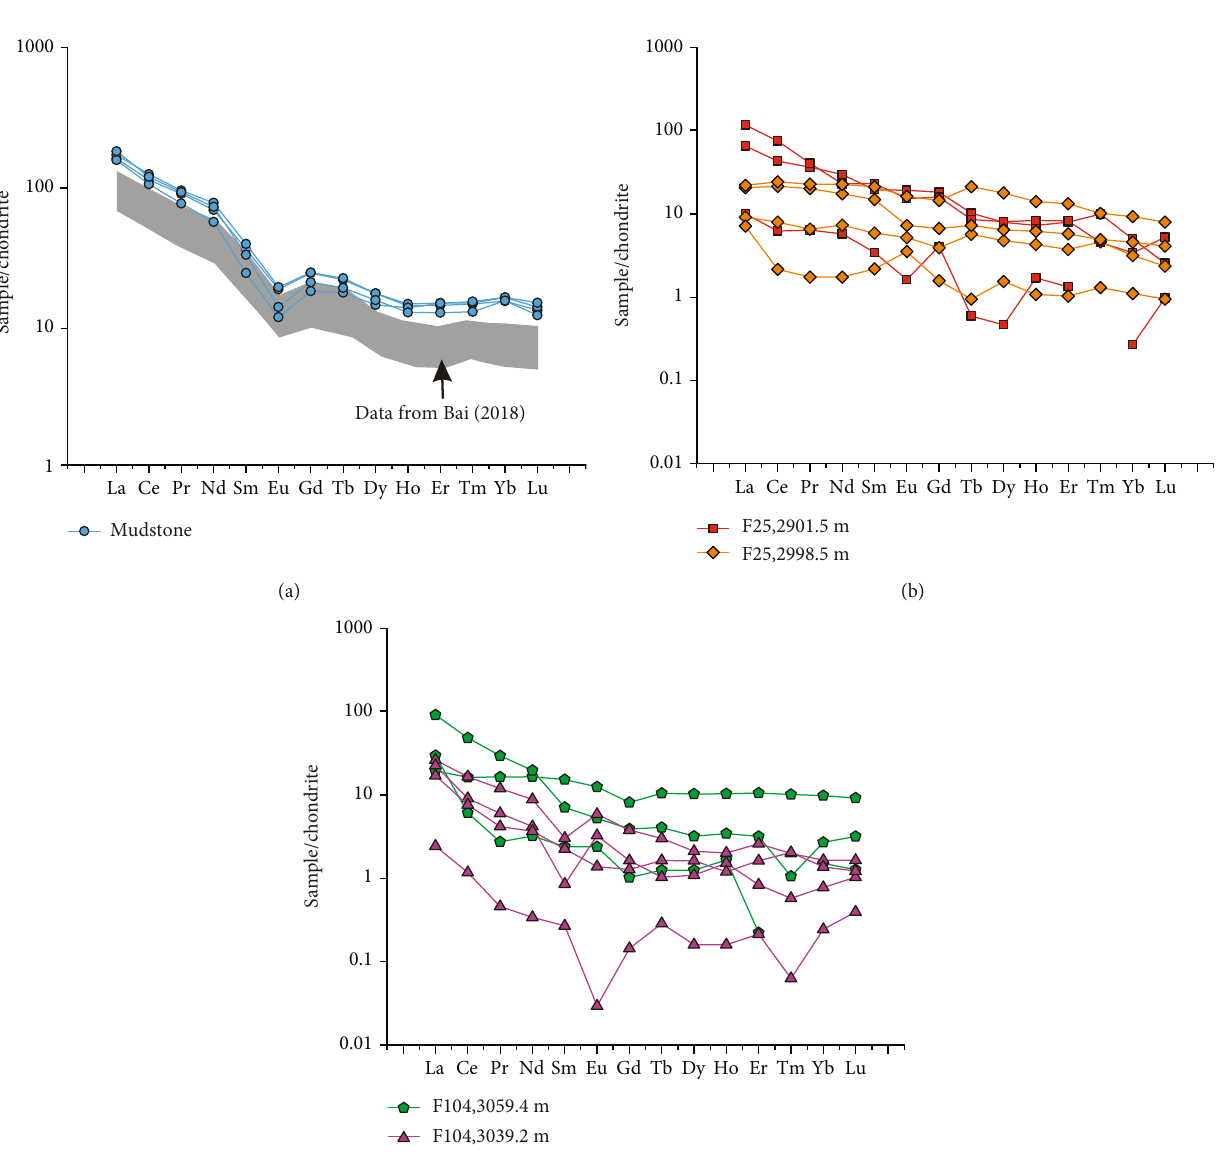
Figure 17: Spider diagram of the pattern of rare earth element (REE). Chondrite-normalized REE patterns in (a) mudstones and data from Bai et al. [14] and in carbonate cements within Es3x interval from (b) F25 and (c) F104 wells,